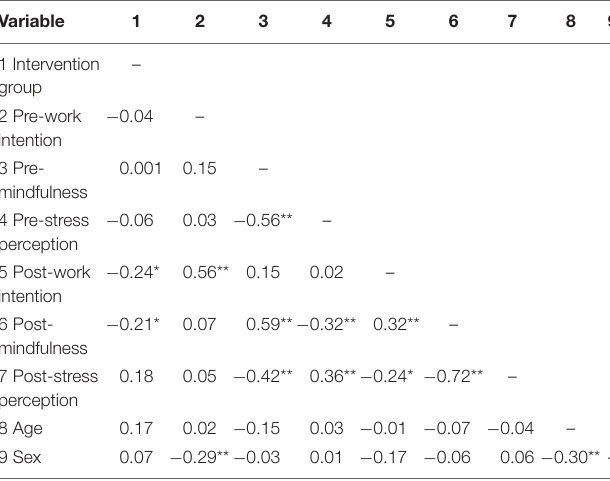
TABLE 3 | Correlations between research